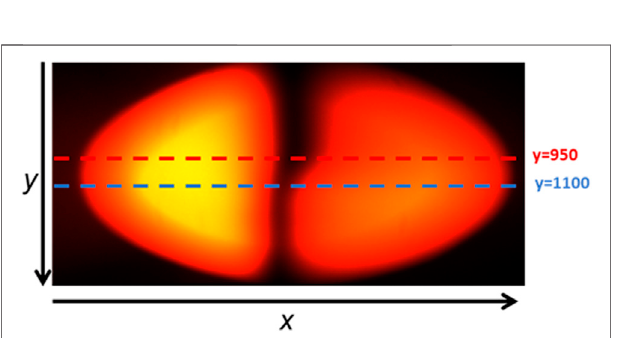
FIGURE 3 | A schematic illustration of the ATR measurement setup with a cylindrical focusing lens and CMOS camera for measuring the surface plasmon resonance (SPR) from the wedge-shaped Au thin fi lm. t Au denotes the designed Au layer thickness.